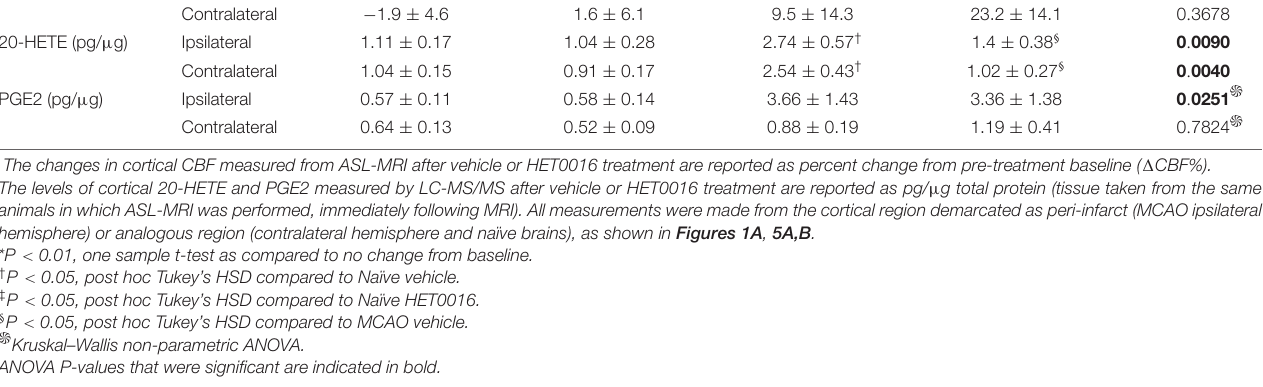
Naïve HET0016 ( n = 6 animals)